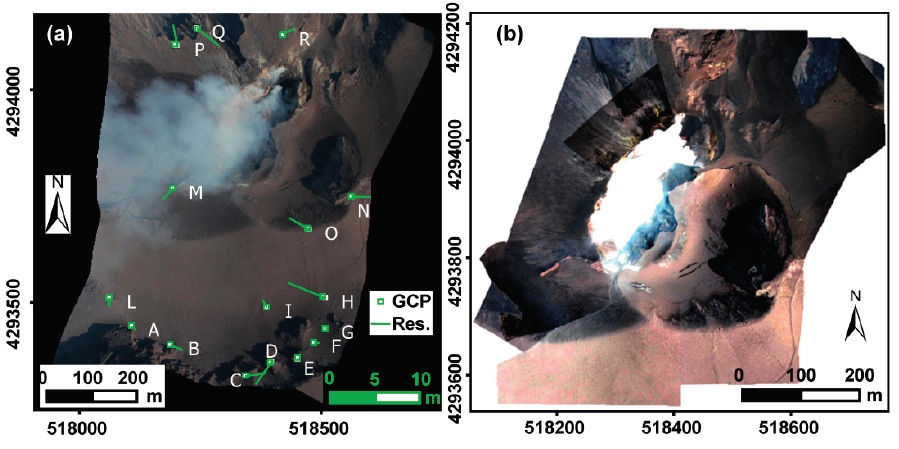
Figure 6. Test 1—Stromboli summit area: ( a ) Orthorectified image acquired on Stromboli crater area after the 2002–2003 eruption showing the residuals (Res.) obtained on the GCPs. The scale bars of the orthorectified image and of the GCP residuals are shown in black and green, respectively; ( b ) Mosaic of the orthophotos necessary for mapping the whole crater